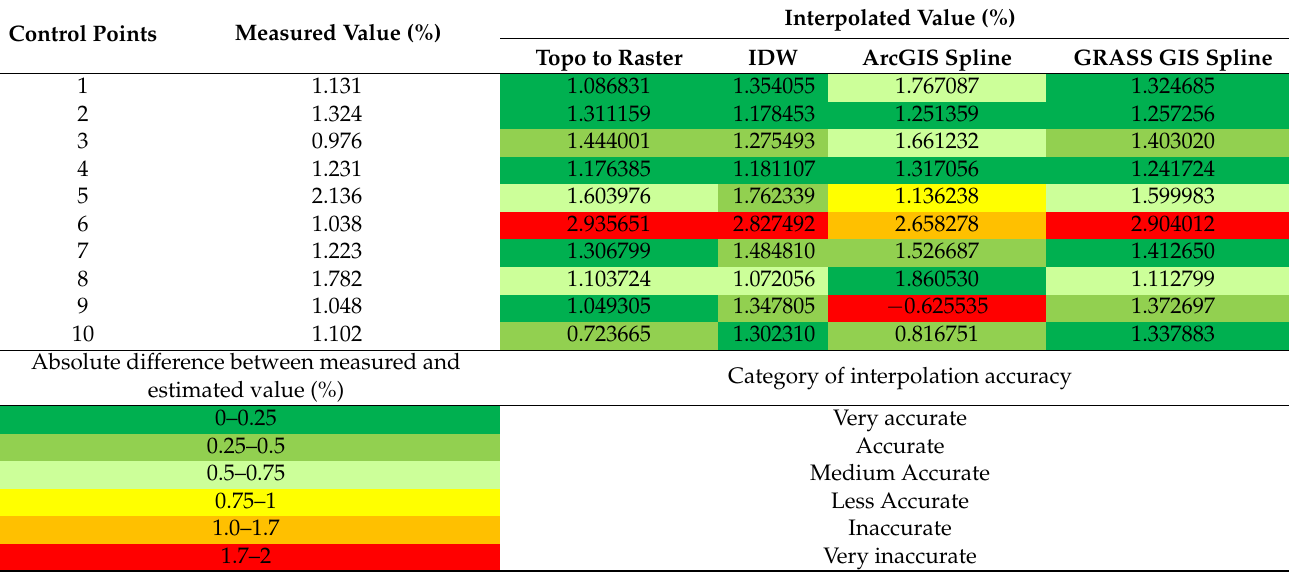
Table 3. Evaluation of the accuracy of soil organic carbon content interpolation.